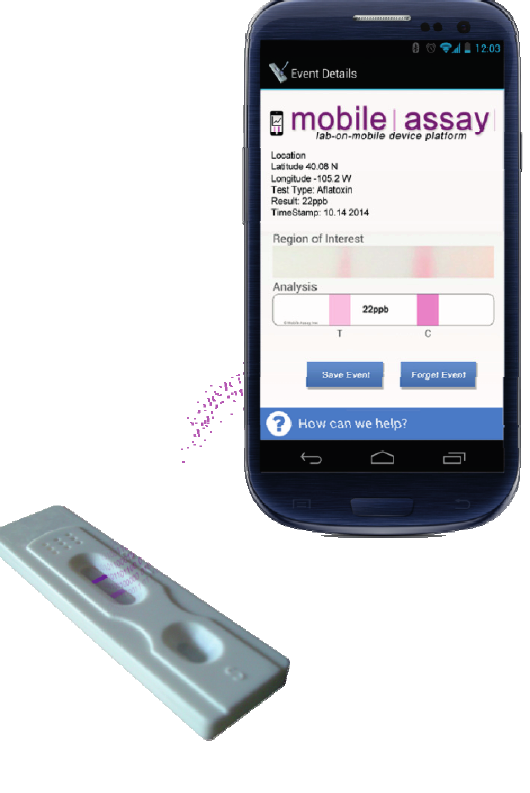
Figure 4. The mobile diagnostic reader (mReader™) by Mobile Assay, Inc. Image provided by Michael Williams, Mobile Assay,